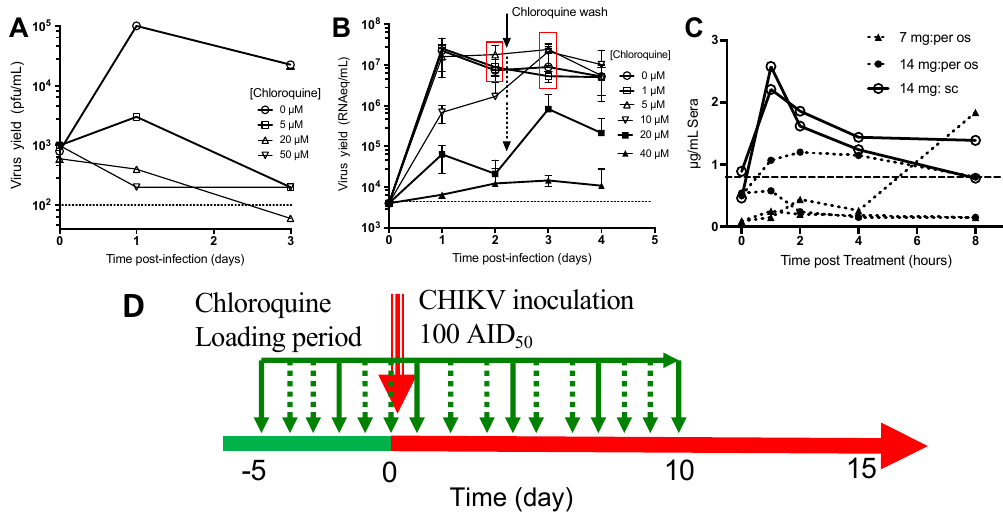
Figure 1. Chloroquine inhibition of Chikungunya virus (CHIKV) replication in cynomolgus macaque cells in vitro and pharmacokinetics in vivo. ( A ) Antiviral activity of chloroquine against the CHIKV infection of macaque primary monocyte-derived macrophages (MDM, quadruplicate; 4–5 × 10 5 MDM per well) were treated for 24 h with various concentrations of chloroquine, infected with a MOI of 3.4. CHIKV levels in the supernatant were quantified by titration on the BHK-21 sensitive cell line, as previously described; ( B ) Primary Fibroblast cells derived from macaque tendon (quadruplicate; 4 × 10 5 per well) were treated for 24 h with various concentrations of chloroquine, infected with a multiplicity of infection (MOI) of 1. CHIKV levels in supernatant were quantified by direct RT-PCR in 30µL of the culture supernatant. At day 2 post-infection, all cells pre-treated with less than 10 µM of Chloroquine and exposed to the virus are dying (red square). The remaining chloroquine was washed out at day 2 and a virus rebound is assessed in the 10 and 20 µM chloroquine treated cells that were killed day 3. Cells that were treated with 40 µM chloroquine were protected from infection but abnormal structures and shape were seen (Supplementary Figure S1b). The data shown either in panel A or B are representative of two experiments, dashed lines are lower limit of quantification; ( C ) Two macaques per regimen were treated for five days with chloroquine. On day 5, blood was taken just before the 6th treatment (time 0), for Cmin determination, or at 1, 2, 4, or 8 h after chloroquine administration. Dashed horizontal line is for Cmin obtained in Human and in macaque after five days of treatment with 14 µg/kg/days of chloroquine. Serum chloroquine concentration was determined as described in the Methods section; ( D ) Scheme of the treatment procedure used during in vivo assay. Chloroquine administration was shown in dotted or solid green arrow, CHIKV inoculation in red arrow and period of infection in animal on red horizontal line.